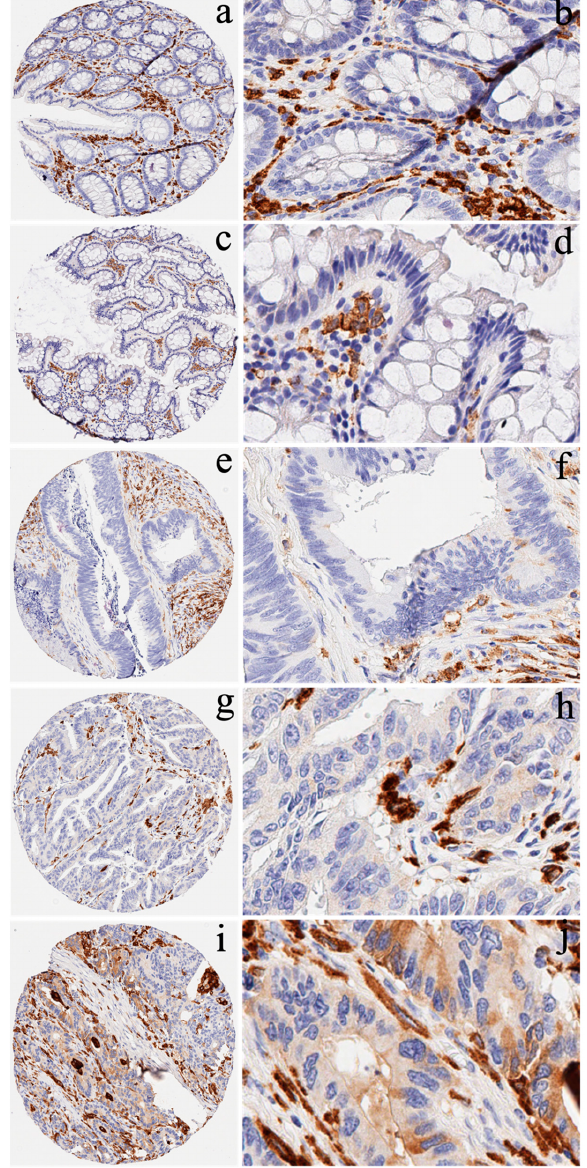
Figure 2. Expression of CD163 in normal colorectal mucosa and cancer tissue using IHC. CD163 was strongly expressed in the macrophages of normal and cancer intracellular matrices. CD163 was neg- atively ( a ): low magnification (×10) and ( b ): high magnification (x40) and slightly expressed ( c ): low magnification (×10) and ( d ): high magnification (×40) in the colorectal epithelial cells. However, CD163 was negatively ( e ): low magnification (×10) and ( f ): high magnification (×40), moderately ( g ):